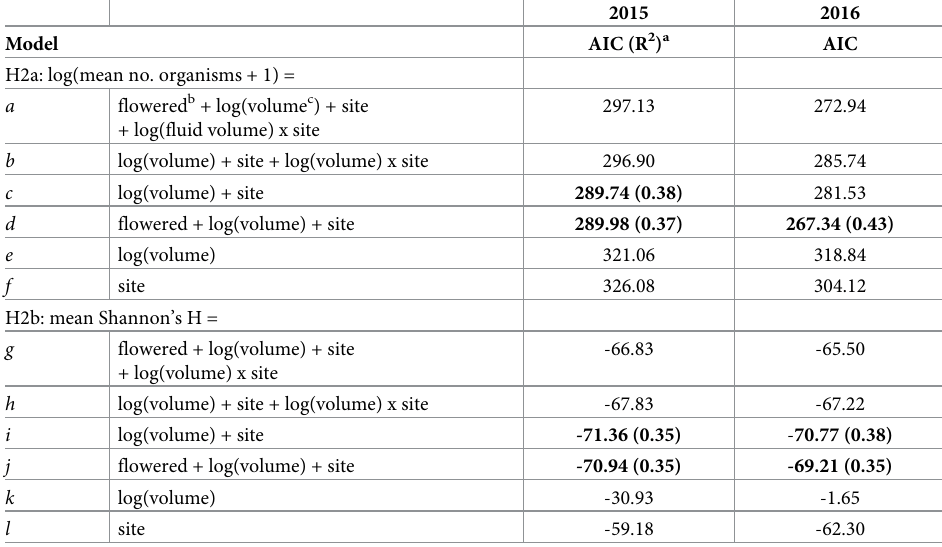
Table 4. Comparison of model fit examining H2 that inquiline abundance and diversity affect reproductive